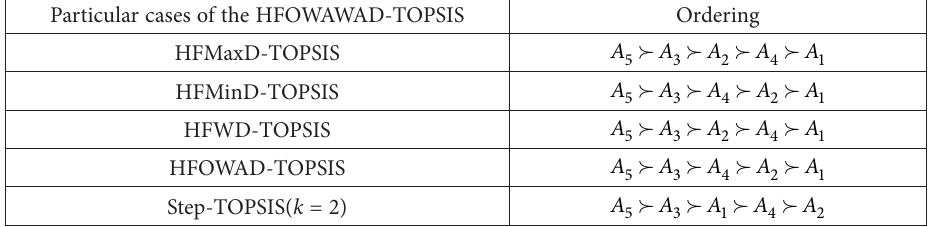
Table 5. Ordering of the airlines